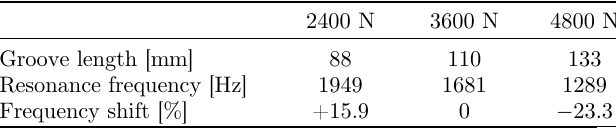
Table 2. In fl uence of the tire load on the footprint length and the theoretical pipe resonance frequencies. The frequency shift in percent is given relatively to the resonance frequency at 3600